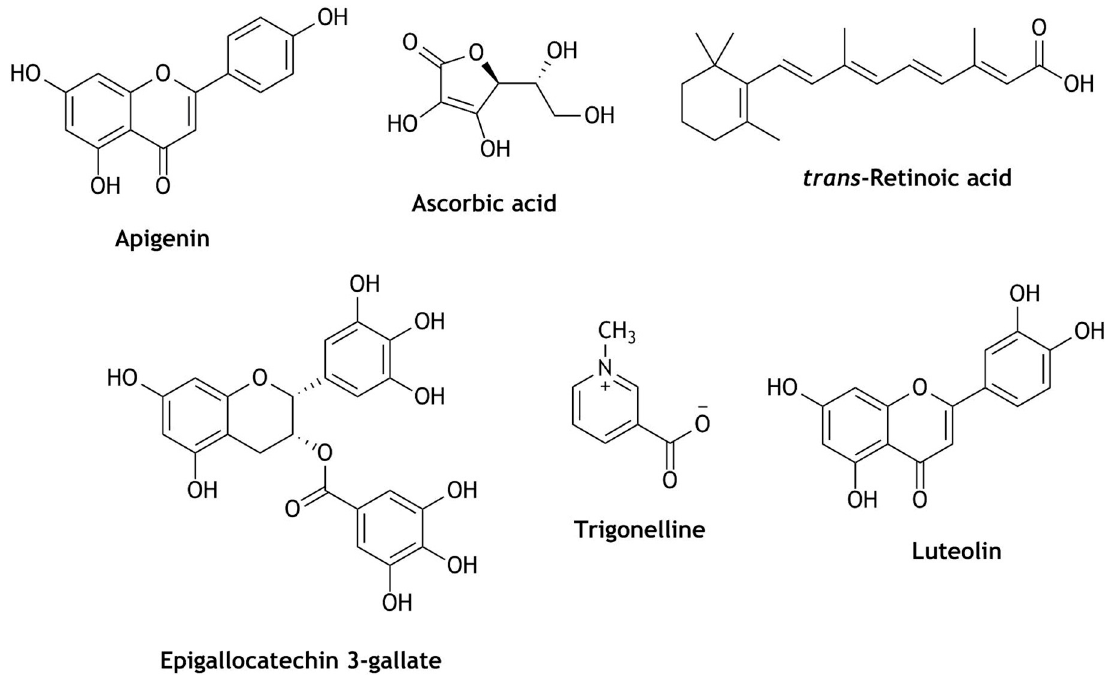
ff ee, juices, and